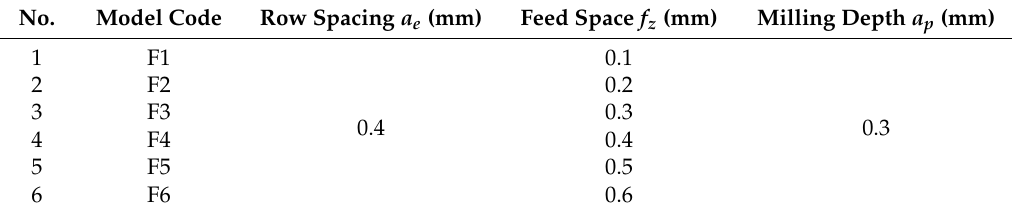
Table 4. Milling parameters of quadrilateral structures over feed space changes.